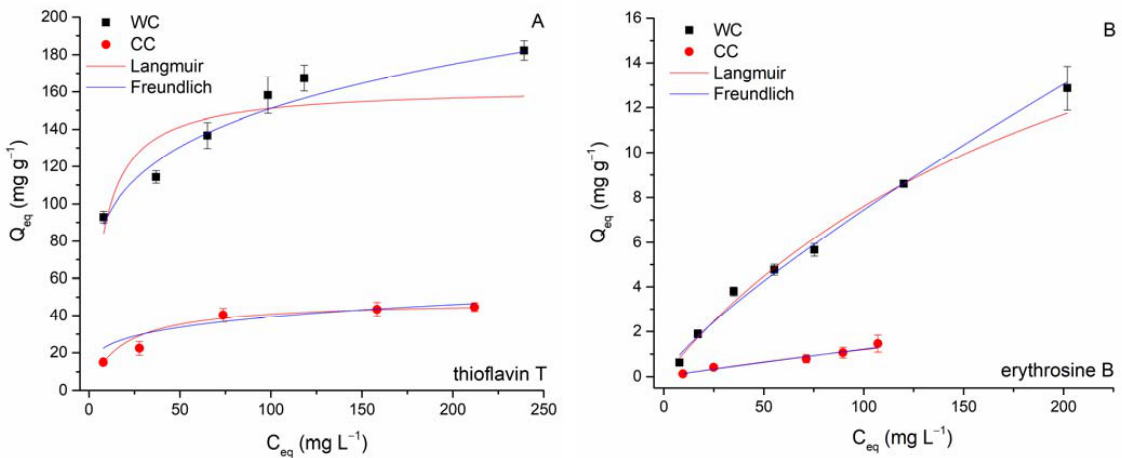
Figure 9. Langmuir and Freundlich isotherms for thioflavin T ( A ) and erythrosine B ( B ) adsorption by wood-chip and corn-cob biochars (8.3 g L − 1 ; T = 22 ◦ C; pH 6.0). Table 4. Parameters of Langmuir and Freundlich isotherms for thioflavin T and erythrosine B ad ‐ Table 5. The maximal adsorption capacities Q max for EB and TT by various adsorbents calculated using Langmuir isotherm